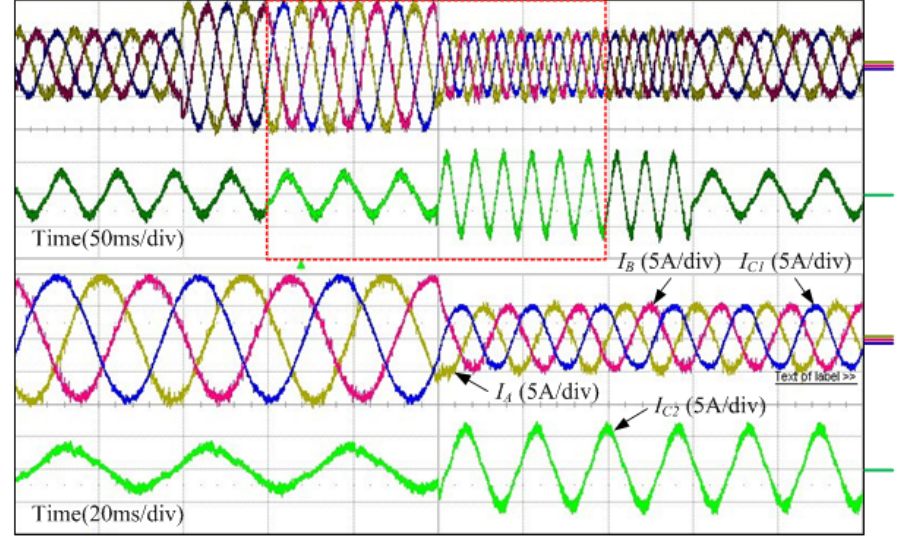
Figure 20. Experimental waveforms magnified for the second variation of the